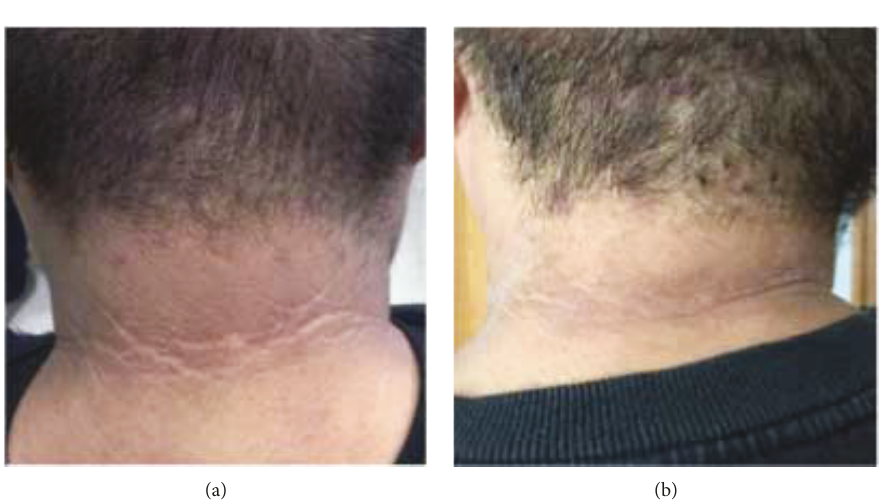
Figure 1: E ff ects of melatonin on acanthosis of neck: a typical case. (a) Baseline. (b) After 12 w